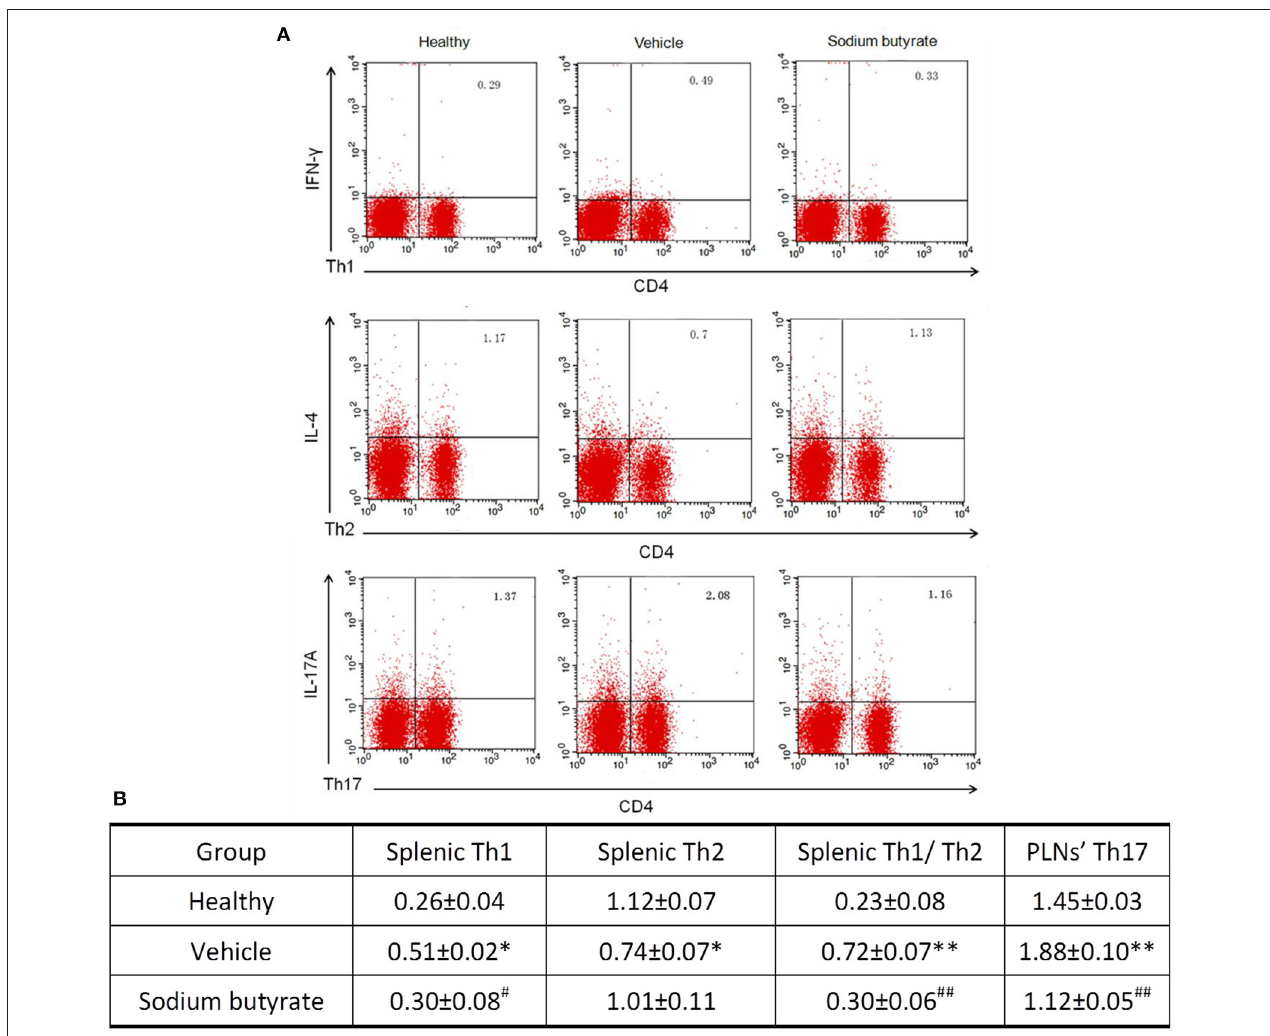
FIGURE 3 | Sodium butyrate treatment regulates CD4 + T cell subsets (A) . Splenic and PLNs’ lymphocyte originated from sodium butyrate treated mice ( n = 5), vehicle group ( n = 5) and healthy mice ( n = 3) were harvested for CD4, IL-4, IFN- γ , and IL-17A staining. The percentages of Th1, Th2, and Th17 cells were determined by flow cytometric analysis (B) . The data are listed in the table as means ± SD of three independent experiment. The ratio of splenic Th1/Th2 and Th17 cell in PLNs was significantly higher than healthy mice, whereas sodium butyrate treatment restored unbalanced Th1/Th2 and regulated Th17 cells to normal level. * p < 0.05, ** p < 0.01 vs. healthy group, # p < 0.05, ## p < 0.01 vs. vehicle